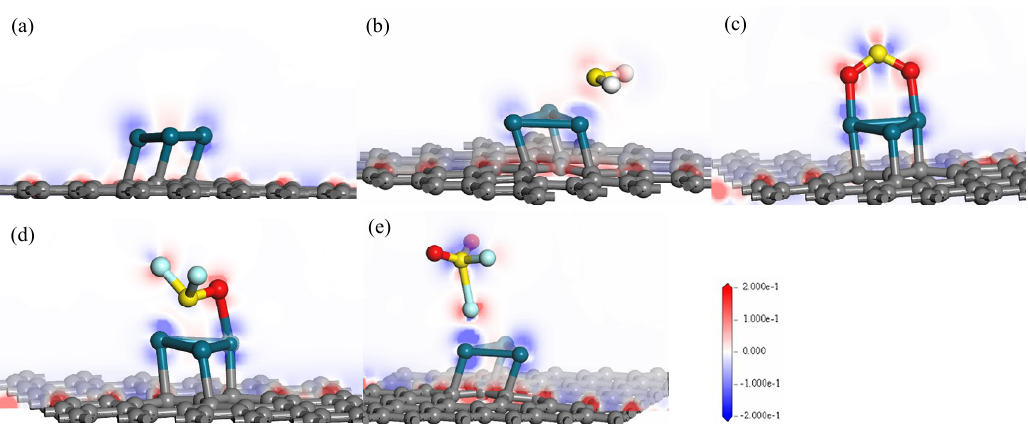
Figure 11. Deformation charge density (DCD) of pure Pd 3 -graphene and the most stable adsorption structures. ( a ) Pure Pd 3 -graphene; ( b ) H 2 S; ( c ) SO 2 ; ( d ) SOF 2 ; ( e ) SO 2 F 2 .